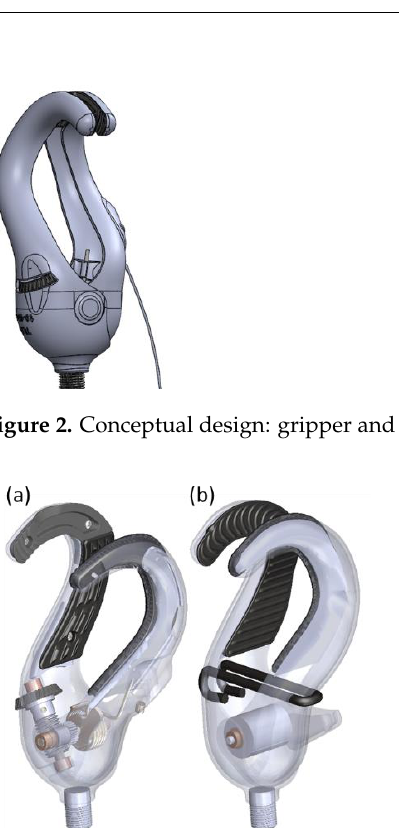
Figure 4. Kinematic diagram.